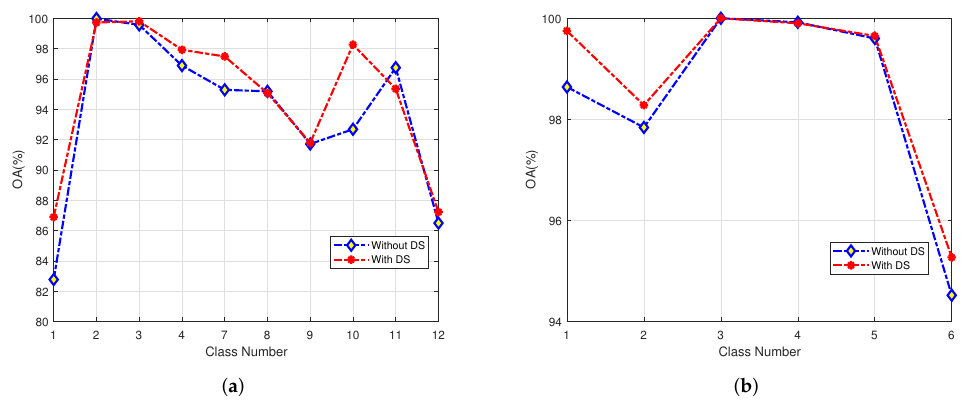
Figure 12. Influence of with/without decision fusion module on classification accuracies of each class. ( a ) 2012 Houston data set. ( b ) Trento data set. Table 9. Influence of with/without Decision Fusion on classification accuracies.